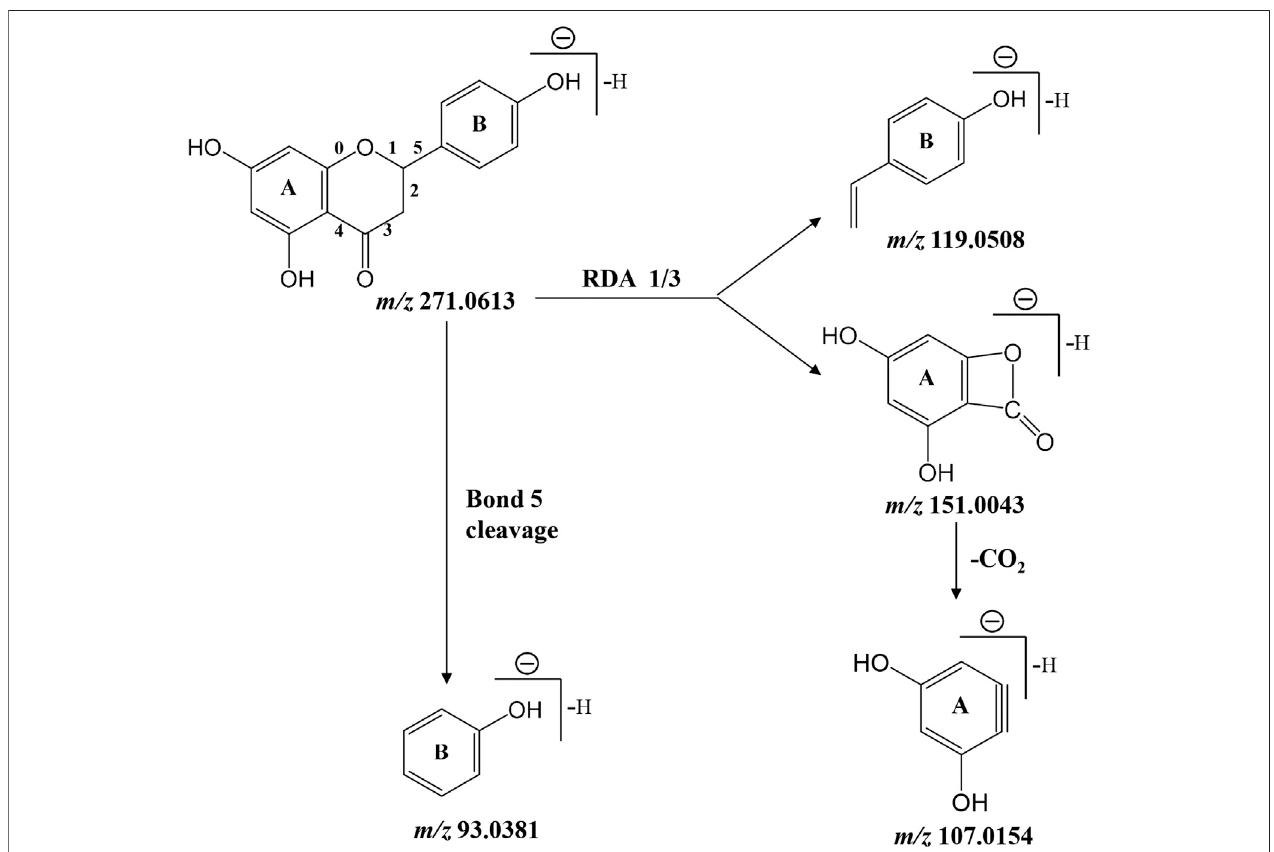
FIGURE 6 | Proposed fragmentation pattern of deprotonated